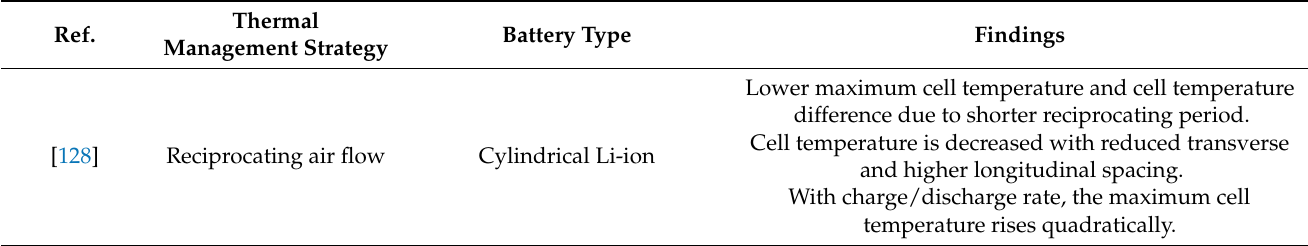
Table 6. Some studies associated with battery thermal management